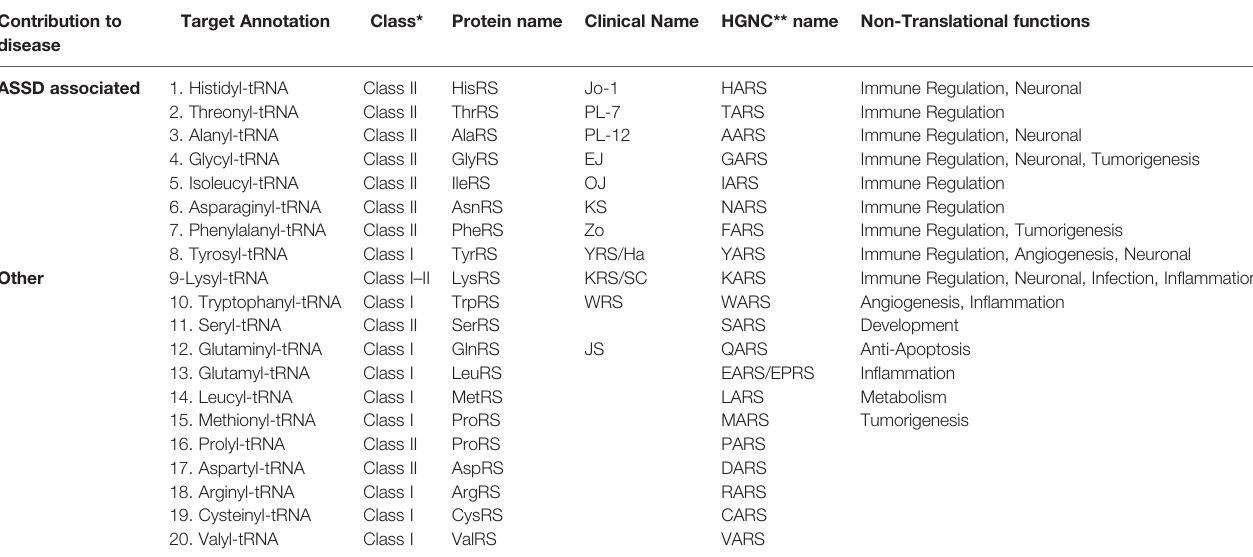
TABLE 1 | Information on aaRSs groups based on their contribution to diseases. Contribution to disease